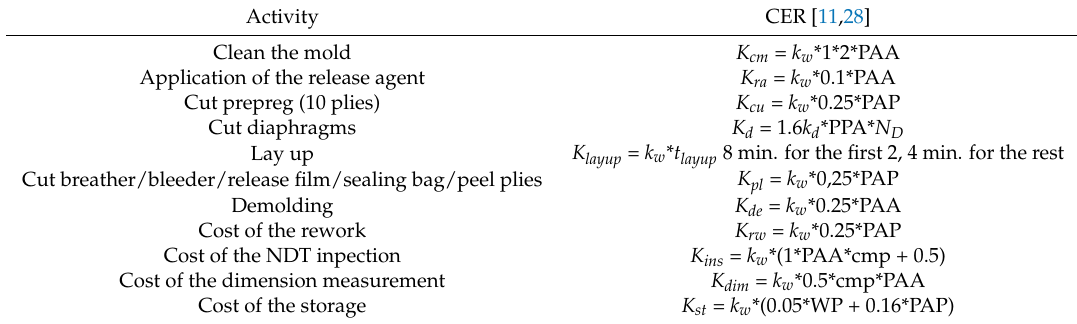
Table 2. Labor cost.